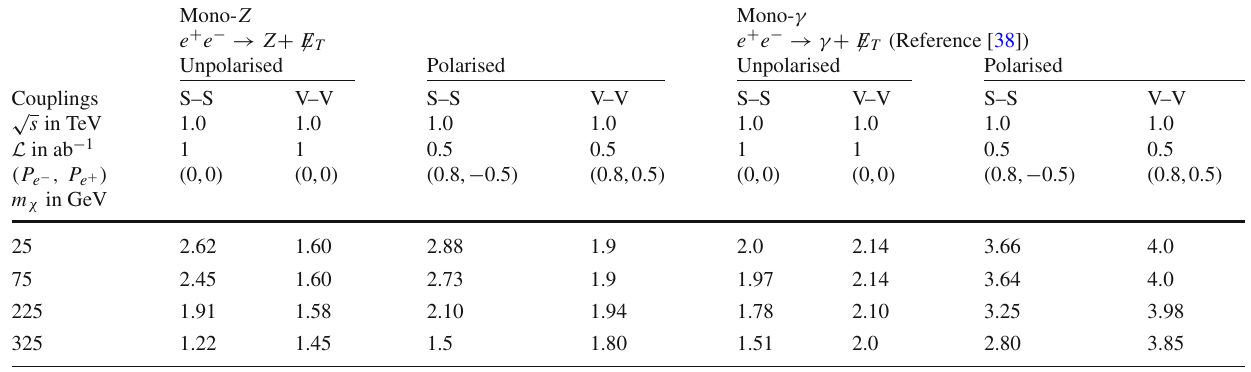
√ B of the process e + e − → j j + (cid:15) E T for m χ Table 5 Efficiency S /